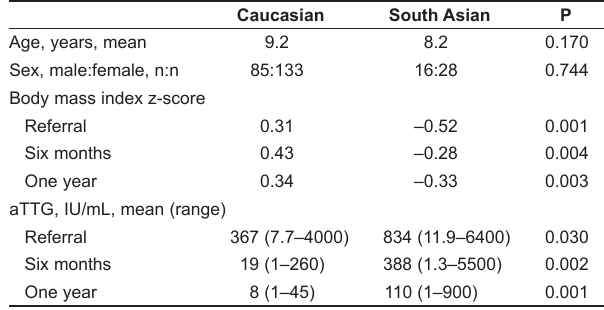
TAble 1 Anthropometric and serological comparisons between Caucasian and South Asian patients between 2008